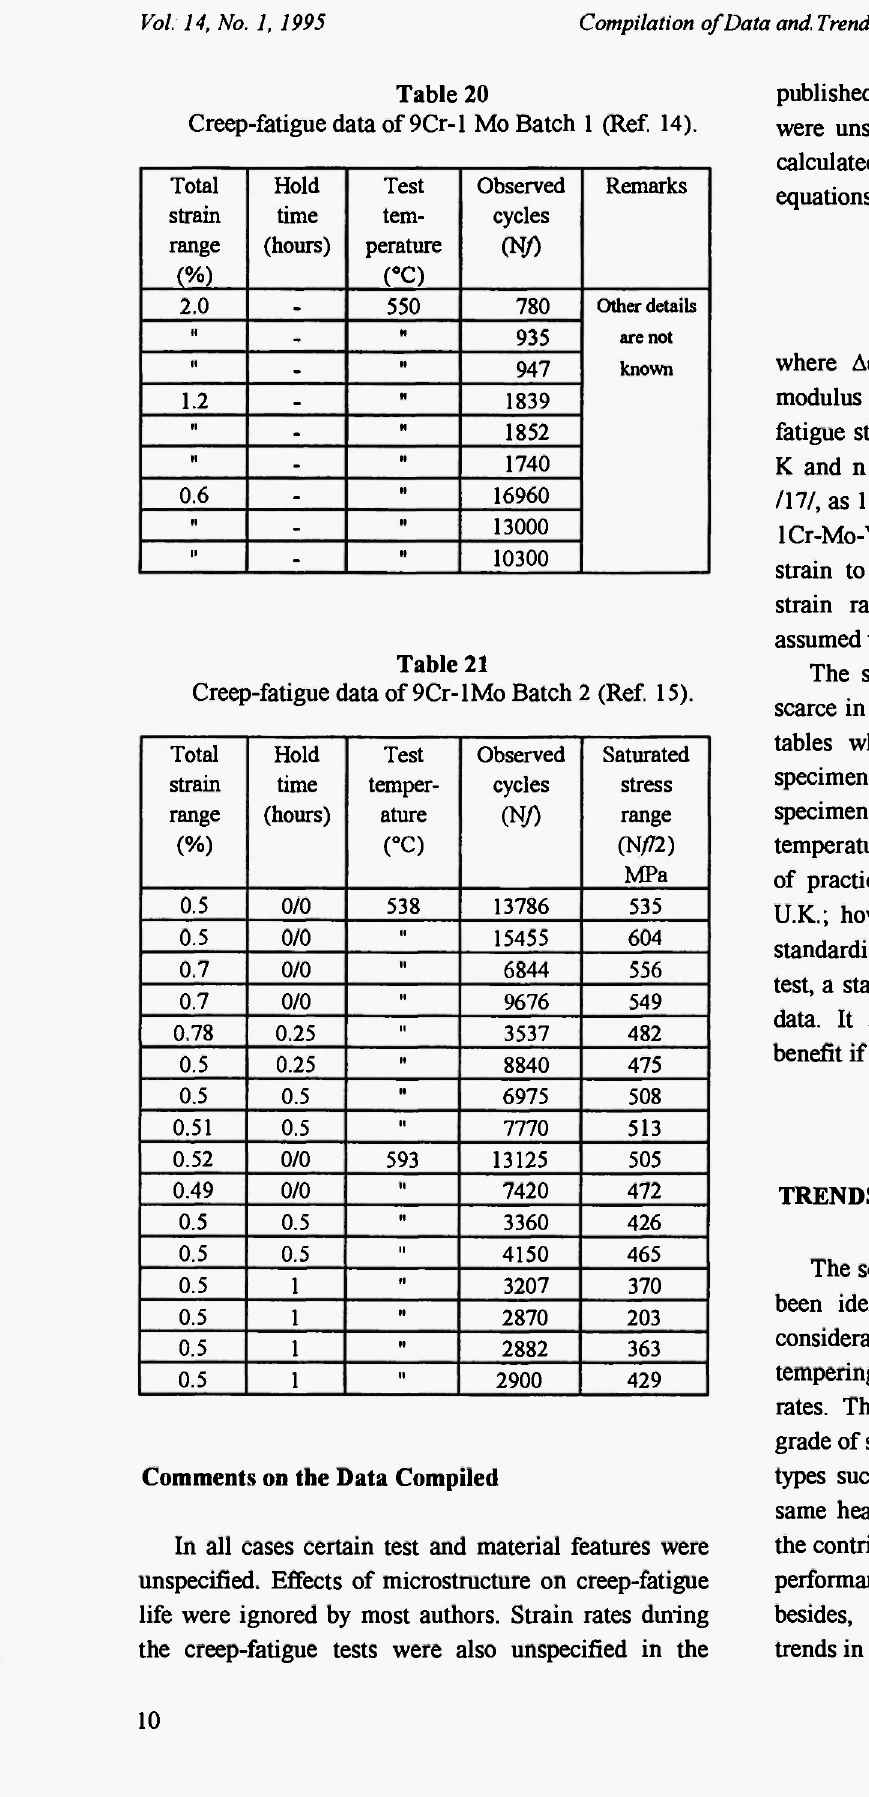
Creep-fatigue data of 9Cr-l Mo Batch 1 (Ref. 14).